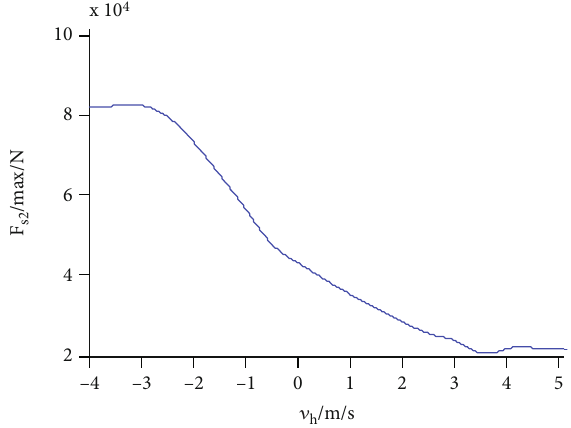
Figure 9: The maximum force of the secondary strut 2 vs. the initial horizontal velocity.